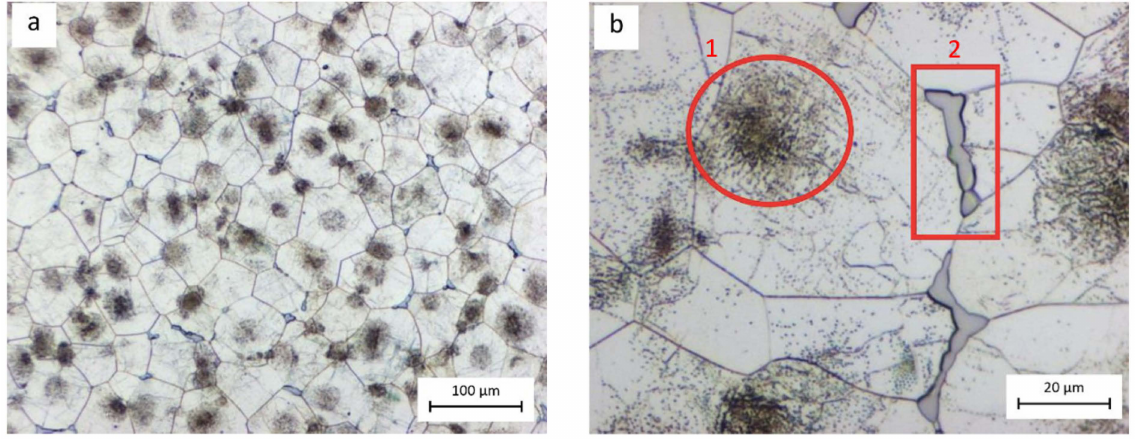
Figure 1. Microstructure of the cast EV31A-T6 Mg alloy after etching with Nital 2 [38]: general view ( a ) and high-magnification detail ( b ) showing Zr-Zn clusters at grain core (1) and residual